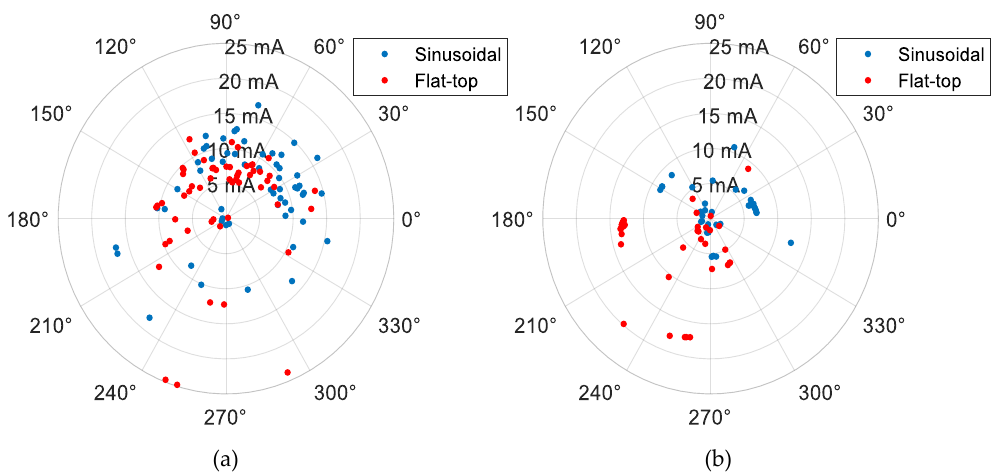
Figure A8. Fifteenth harmonic current emission of the selected lamps under the two types of supply voltage: ( a ) CFL and ( b ) LED lamps.